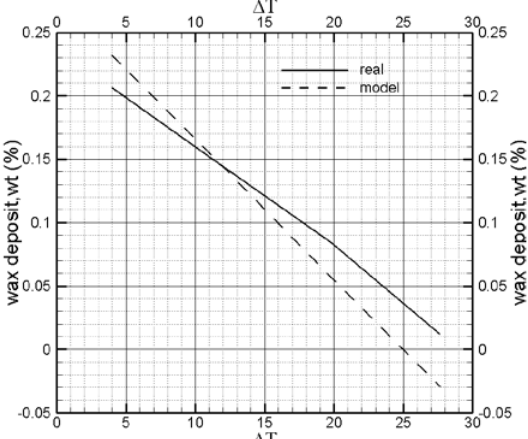
Figure 19 Relationship between Δ T and pipe length (Gooya et al., 2013)